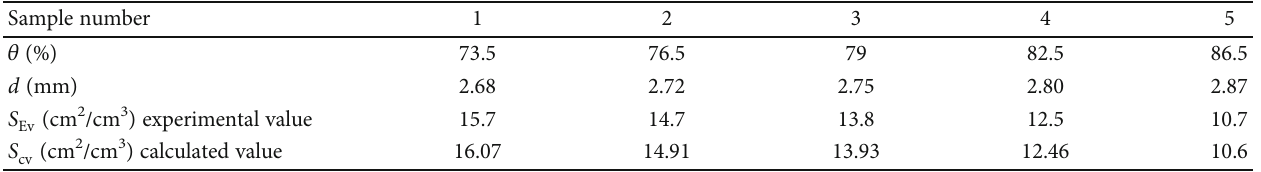
Table 2: Experimental data and theoretical calculation data of aluminum foam.